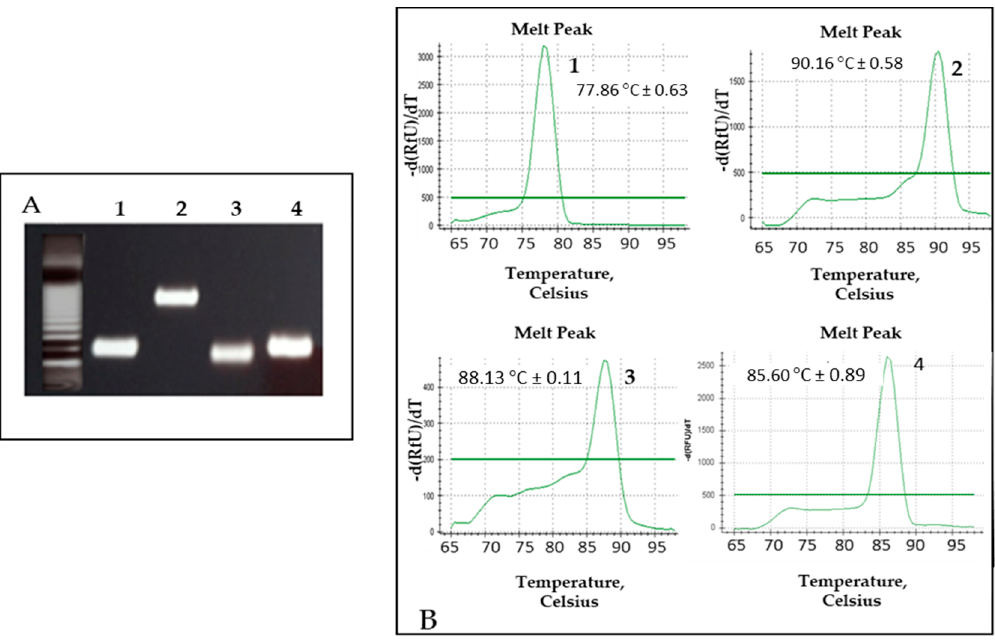
Figure 4. MC-PCR (melting curve PCR) assay results by using DNA from each pathogen. ( A ) Agarose gel electrophoresis with the amplicons generated for each pathogen. Lane: 1. P. jirovecci , 124 bp; 2. H. capsulatum , 398 bp; 3. M. tuberculosis complex, 98 bp; 4. C. neoformans/gatti , 139 bp. ( B ) Melting curves generated with the corresponding melting temperature (Tm): 77.86 °C ± 0.63 ( P.jirovecii ); 90.16 °C ± 0.58 ( H. capsulatum ); 88.13 °C ± 0.11 ( M. tuberculosis complex); 85.60 °C ± 0.89 ( C. neoformans / C. gatti ).